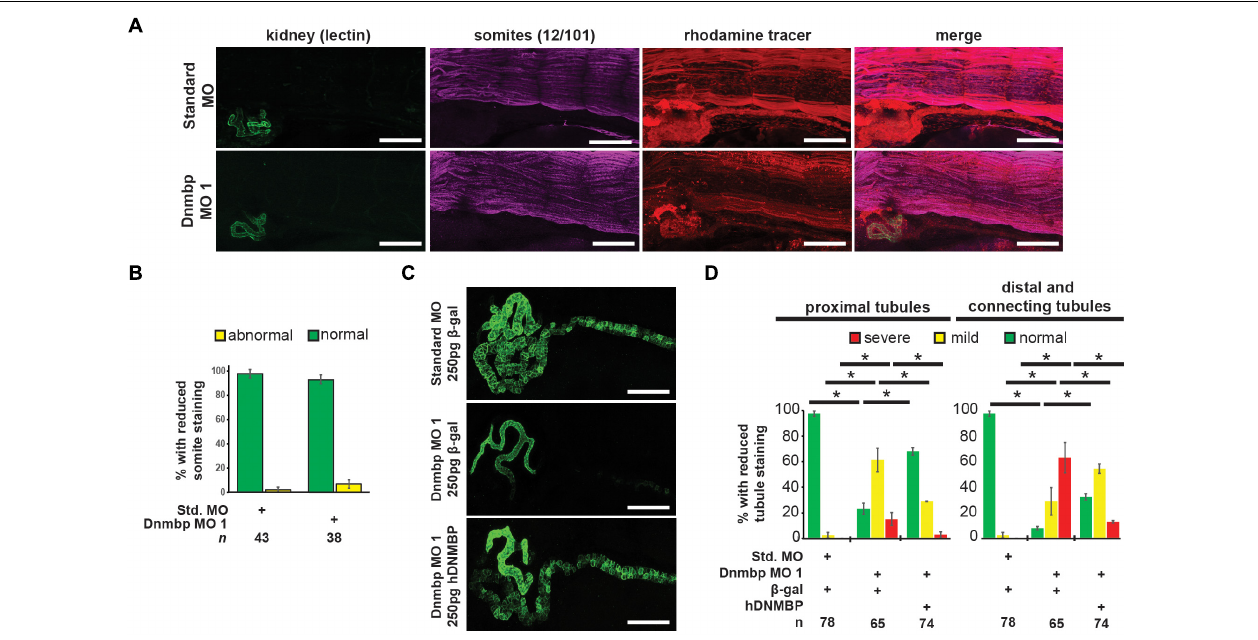
FIGURE 3 | Dnmbp knockdown is specific and does not cause somite development defects. (A) Unilateral injection of 20 ng Dnmbp MO 1 into blastomere V2 at the 8-cell stage does not cause somite defects in comparison to embryos injected with Standard MO. 12/101 antibody labels somites, lectin labels the proximal tubule lumen, rhodamine used as a tracer. Images are stitched from 6 tiles. White bar is 200 µ m. (B) Knockdown of Dnmbp does not lead to reduced somite development compared to embryos injected with Standard MO. (C) Representative embryos showing that co-injection of β -galactosidase RNA with Dnmbp MO 1 does leads to kidney defects in comparison to control embryos injected with Standard MO and β -galactosidase RNA. Co-injection of human DNMBP mRNA with Dnmbp MO 1 rescues the knockdown phenotype. Stage 40 embryos stained with antibody 3G8 to label the proximal tubule and antibody 4A6 to label the distal and connecting tubules. White bar is 200 µ m. (D) Quantitation of the rescue phenotype. n = number of embryos across 3 replications. Error bars represent Standard error. ∗ Significantly different, p < 0.05.